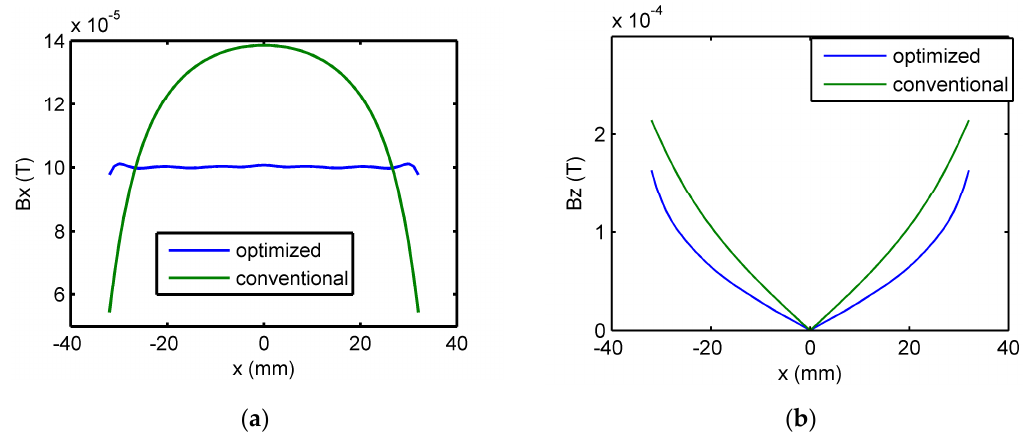
Figure 7. Numerical simulation results of ( a ) (cid:1828) (cid:3051) at the observation points and ( b ) (cid:1828) (cid:3053) at the sensor array for the cases of optimized coil and uniform coil.